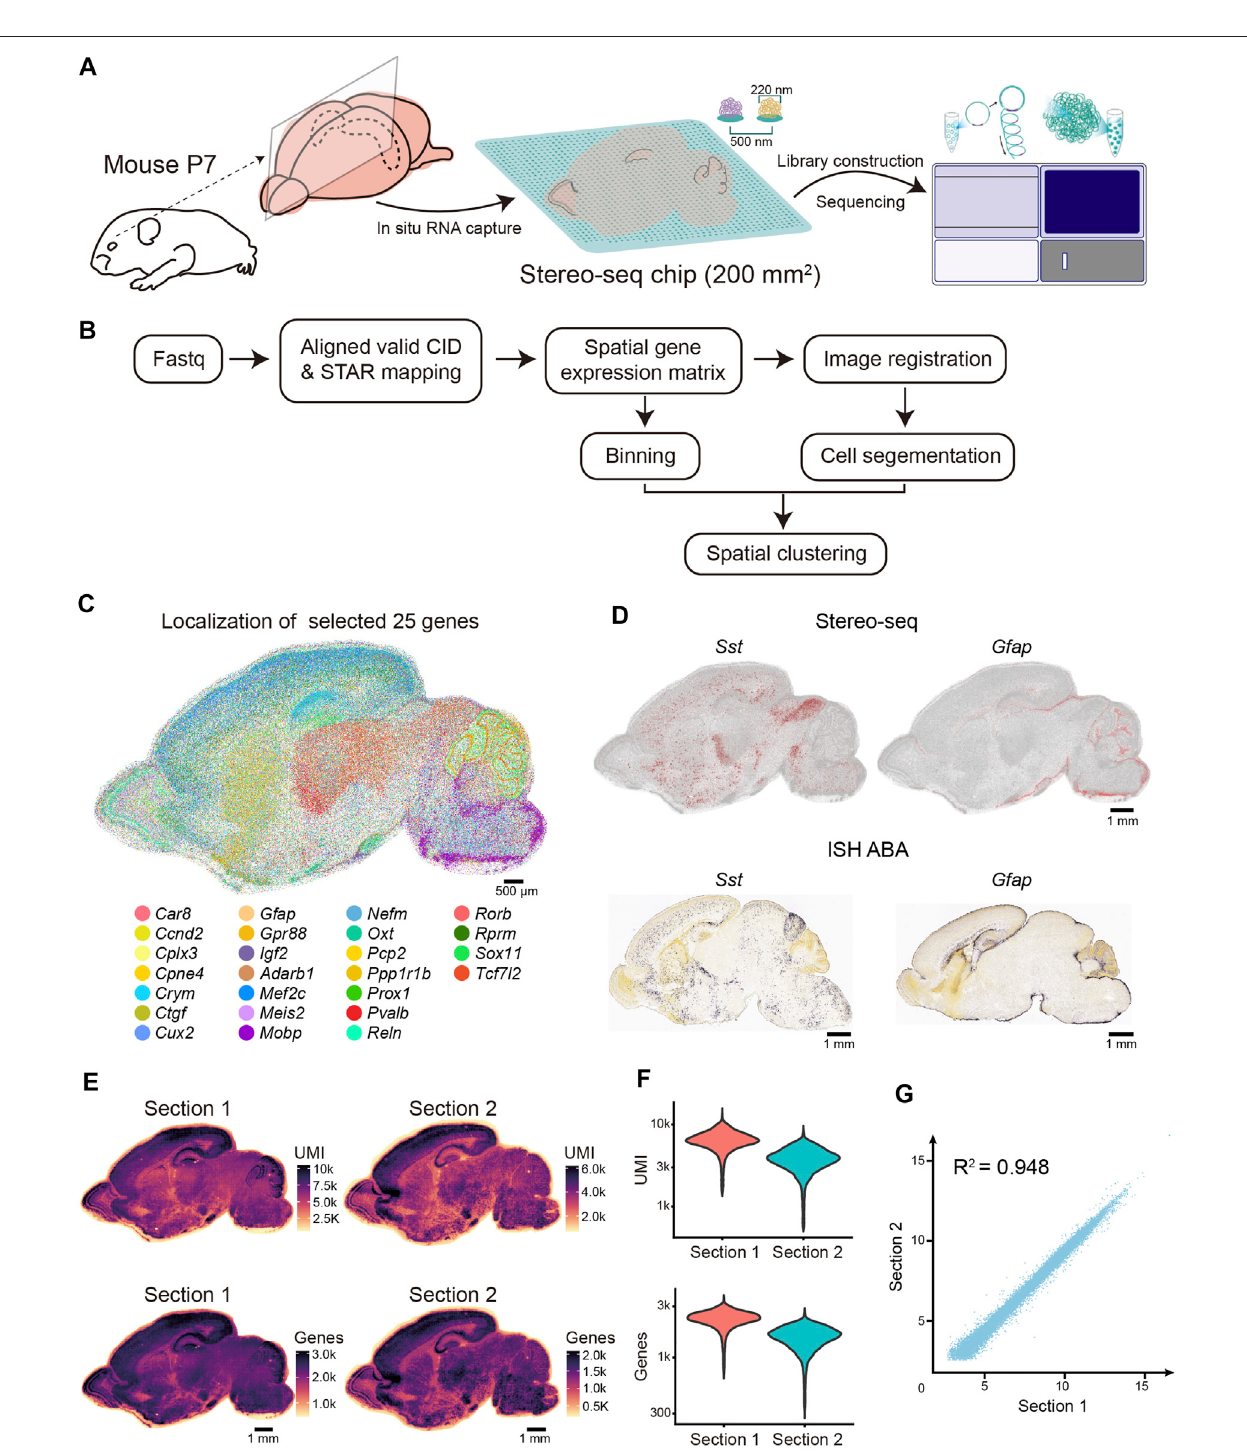
FIGURE 1| Overview ofthe experimental method, data analysiswork fl ow, and Stereo-seq data quality. (A) Schematic representation ofthe Stereo-seq work fl ow. Left, sagittal sections near the middle line were collected for the Stereo-seq pro fi ling. Middle, in situ RNA capture from tissue. The effective area of chip in this study is 200 mm 2 . Spot size and center-to-center distance of Stereo-seq chip are 200 nm and 500 nm respectively. Right, library construction and sequencing. (B) Graphic representationofStereo-seqanalyticalwork fl ow. (C) Molecularlocalizationofthe25selectedgenes.Eachdotrepresentsacaptured gene.Scalebar,500 µm. (D) Top:Spatialvisualizationof Sst and Gfap localizationoftheP7mousebrainsection.Bottom:ISHimagesof Sst and Gfap localizationoftheP4mousebrainsectiontaken from ABA. Scale bars, 1 mm. (E) Spatial distribution of UMIs and genes (bin 50) per section. Scale bars, 1 mm. (F) Violin plot indicating the distribution of the UMI and genes (bin 50) per section. (G) Pearson correlation coef fi cient ( R 2 = 0.948) between the two replicates.